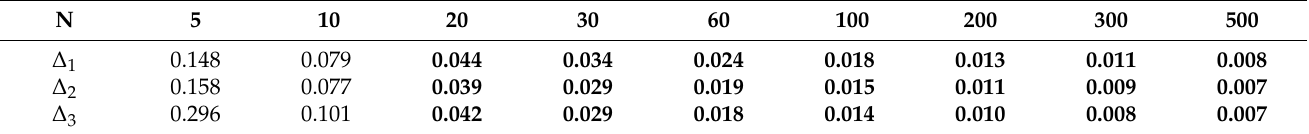
Table 3. Kolmogorov distances, comparing simulation results and asymptotic values for the total capacity of customers of different types for the QS GI ( ν ) |GI| ∞ . Bold format highlights results that do not exceed the value of the acceptable approximation